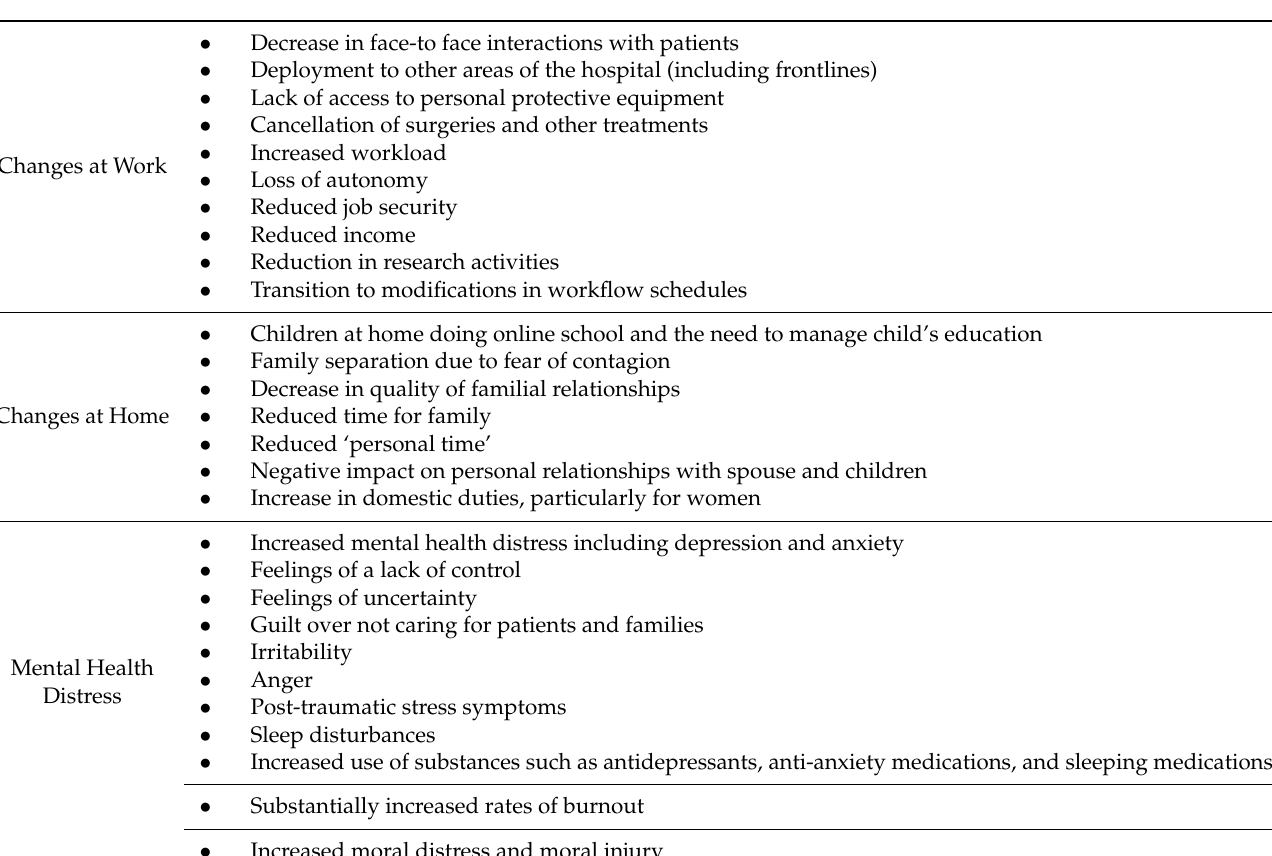
Table 2. Impact of COVID-19 Pandemic on Oncology Healthcare Professionals’ Mental